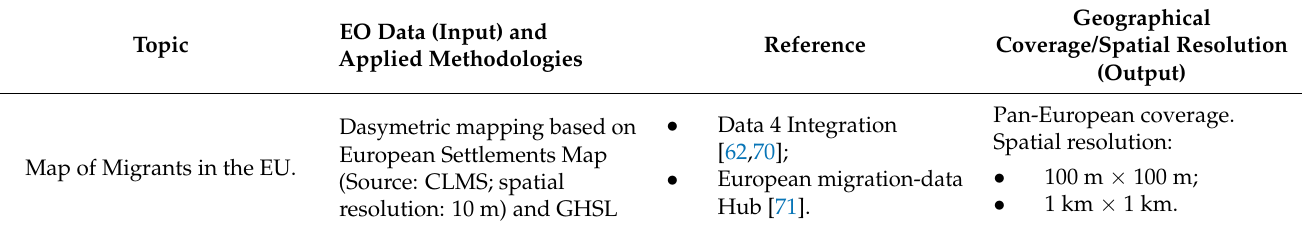
Table 2. Collection of reference bibliographies on population datasets from EO